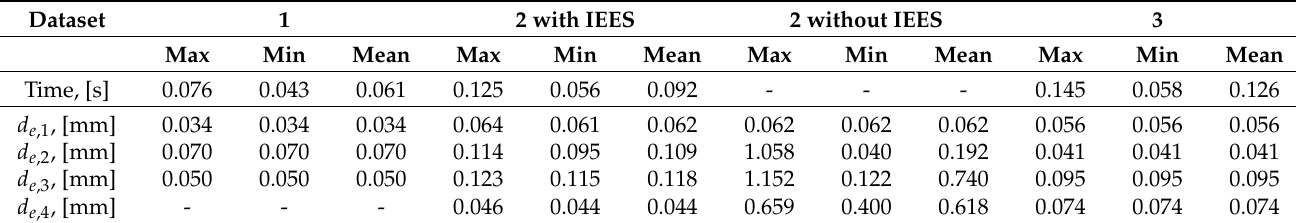
Table 2. Segment fit errors and execution times for 10 sequential runs using the datasets 1, 2, and 3. Results for dataset 2 are given with and without iterative error elimination step (IEES). The fit error definition is given in the beginning of Section 4. Dataset